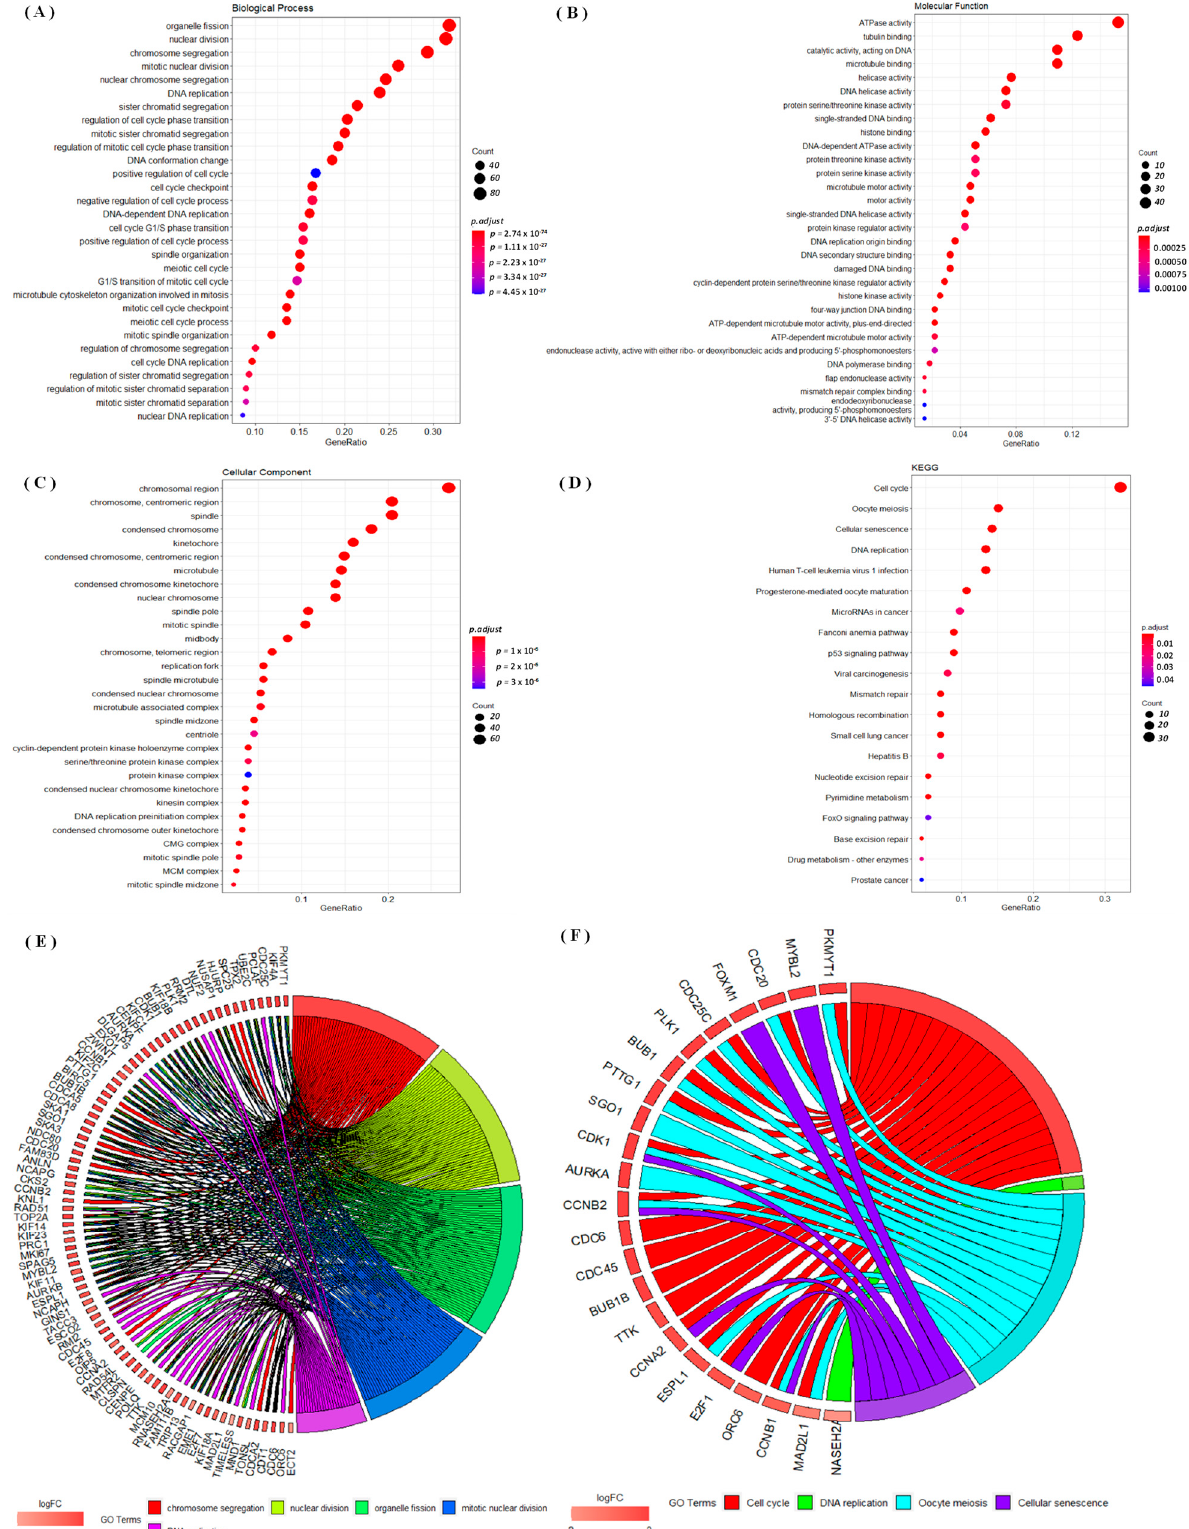
Figure 6. Gene ontology (GO) analysis based on genes co-expressed with NEK2 from the associated METABRIC and TCGA datasets. ( A ) Dot plot of biological processes. ( B ) Dot plot of cellular components. ( C ) Dot plot of molecular functions. ( D ) Dotplot of KEGG. The dot size is determined by the count of enriched genes in the pathway, and the color of the dots represents the pathway enrichment’s significance. We used the “clusterProfiler” package in R/Bioconductor to perform the GO analyses of dot plots. ( E ) Chord plot of relationships between genes and GO terms of biological processes. ( F ) Chord plot of relationships between genes and GO terms of KEGG.